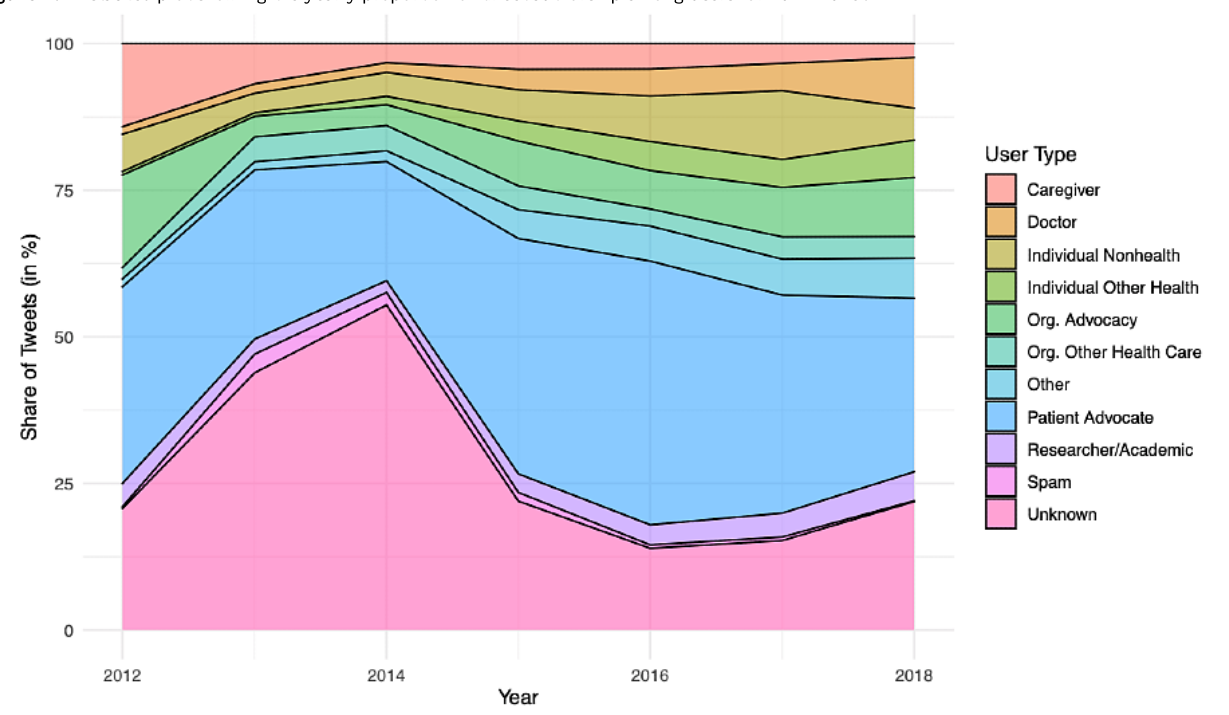
Figure 2. A stacked plot showing the yearly proportion of tweet authorship among users for